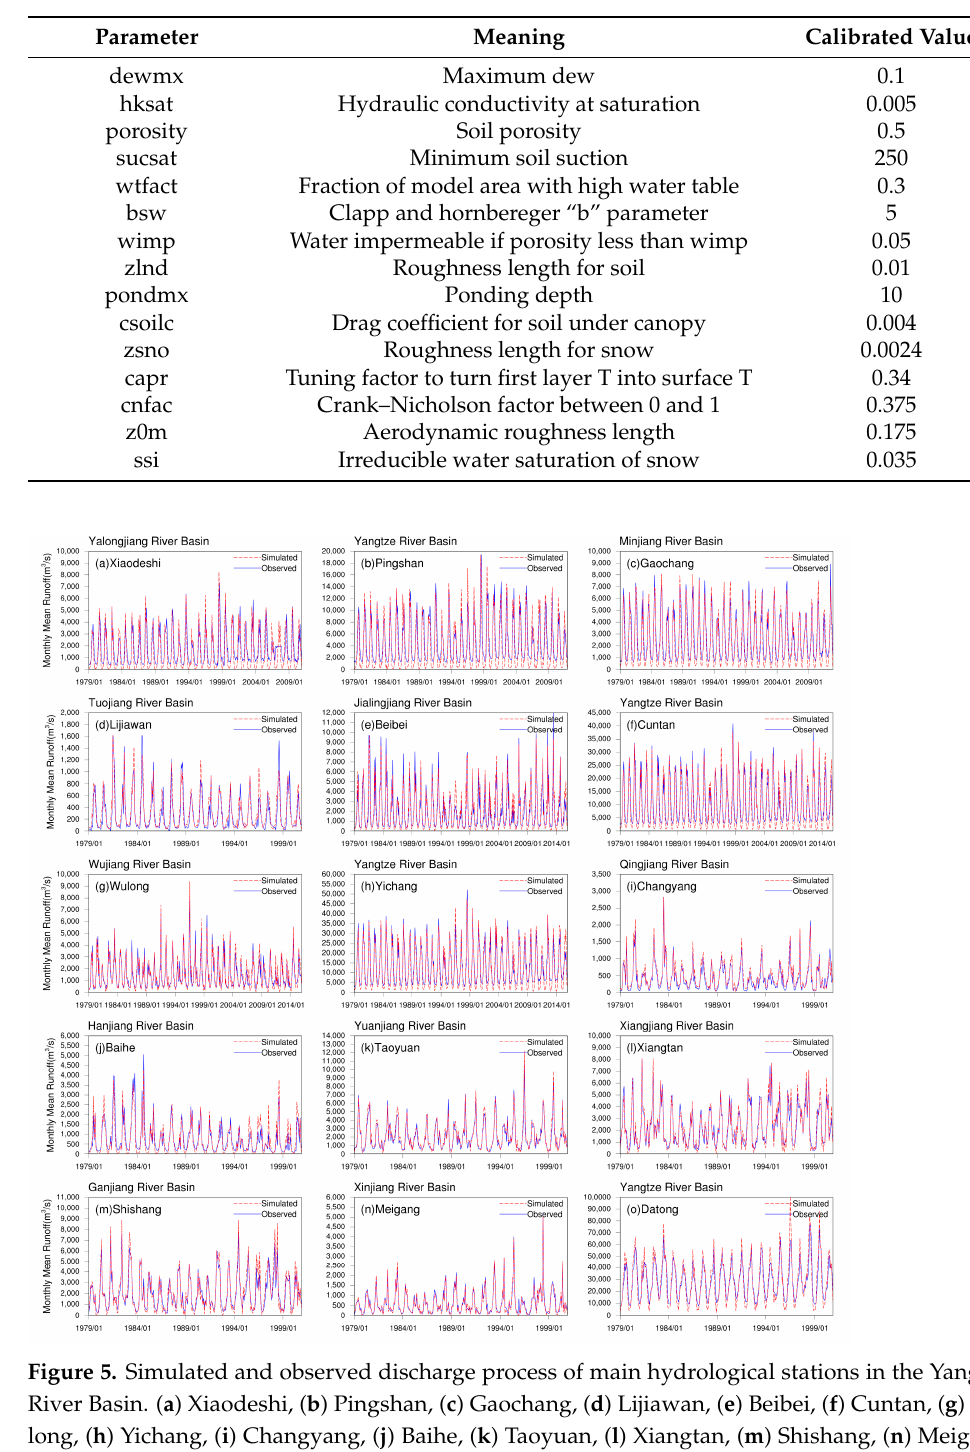
Table 3. Parameters, meanings and calibrated values of CLM model.